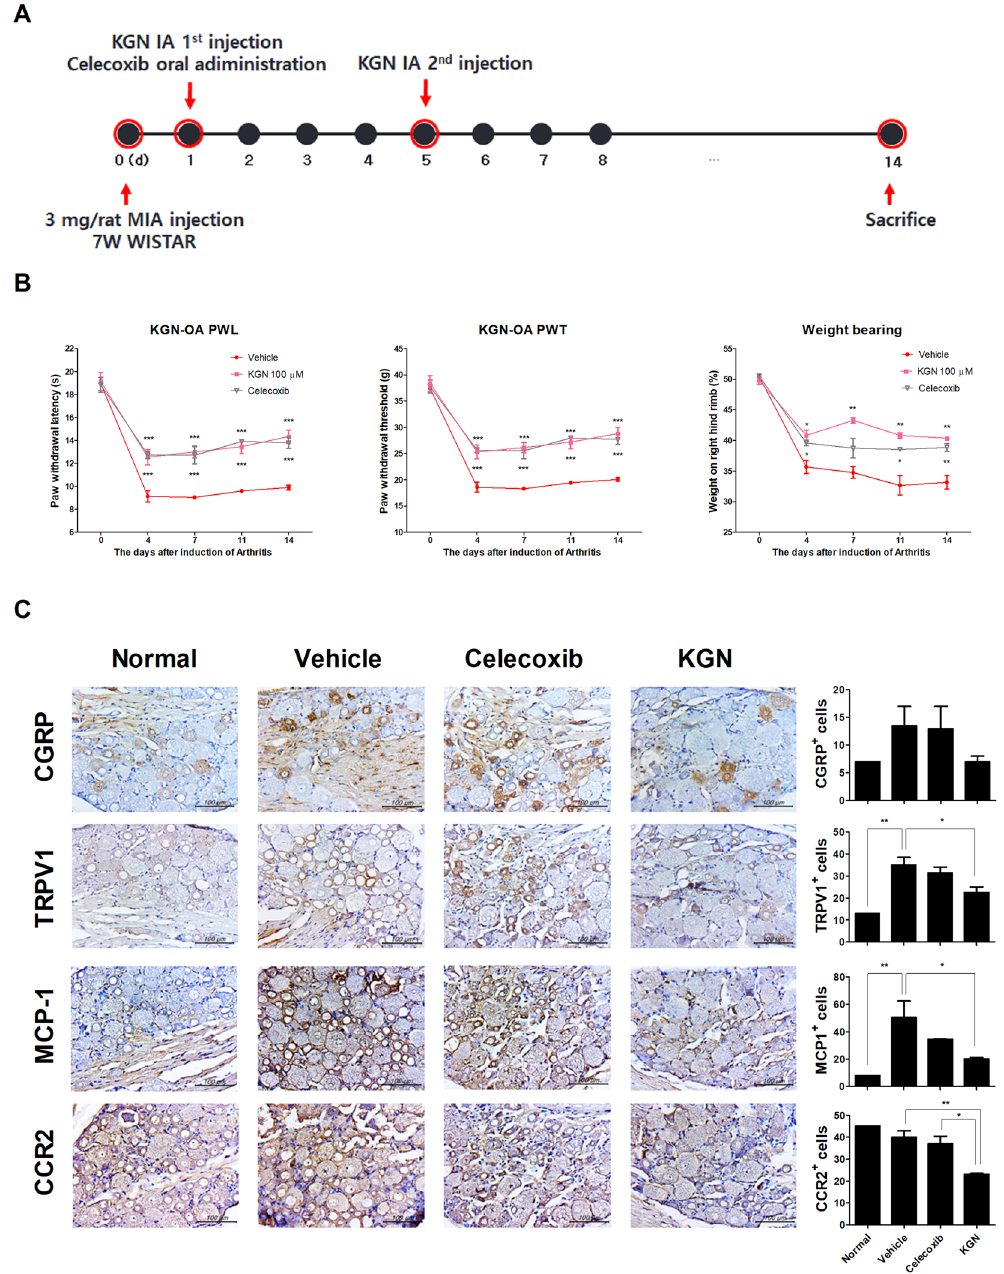
Figure 1. Therapeutic effect of KGN in an initial stage of MIA model. KGN decreased pain and inflammatory factors in the dorsal root ganglion from an OA rat. ( A ) OA induction by IA injection monosodium iodoacetate into Male Wistar rats. Rats were treated with intra-articular injection of KGN (100 μ M) or saline (vehicle), 1 and 5 days after MIA injection. Celecoxib (12.5 mg/rat) was given daily by oral administration to MIA- induced rats. ( B ) Conducting experiment mechanical pain were analyzed PWL and PWT on the paw. The right patellar weight-bearing asymmetry in rat models of osteoarthritis is also shown. ( C ) IHC staining was analyzed to measurement the level of CGRP, TRPV1, MCP-1, and CCR2 in the dorsal root ganglion (DRG) of OA rats. Tissue analysis was carried out two times in 3 animal models. These experiments were performed in five individual animal experiments. * P < 0.05, ** P < 0.001, *** P < 0.005, comparison to vehicle. Data are representative of three